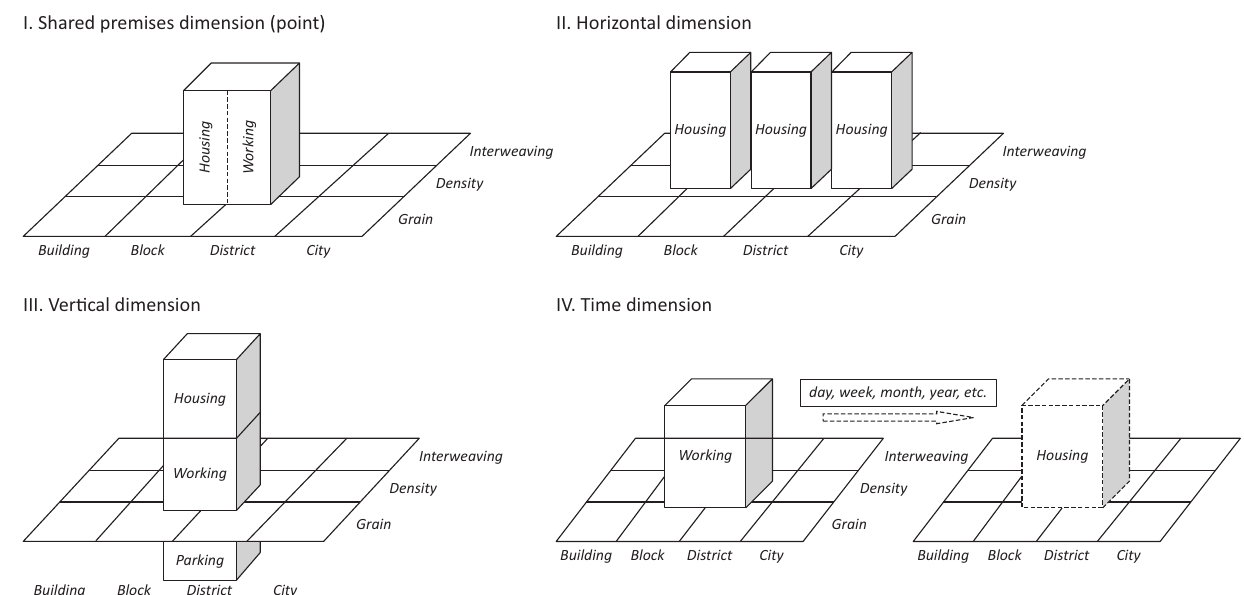
Figure 1. Multidimensional typology of mixed‐use by Hoppenbrouwer and Louw (2005, p. 973): A conceptual model of mixed land use for four dimensions.